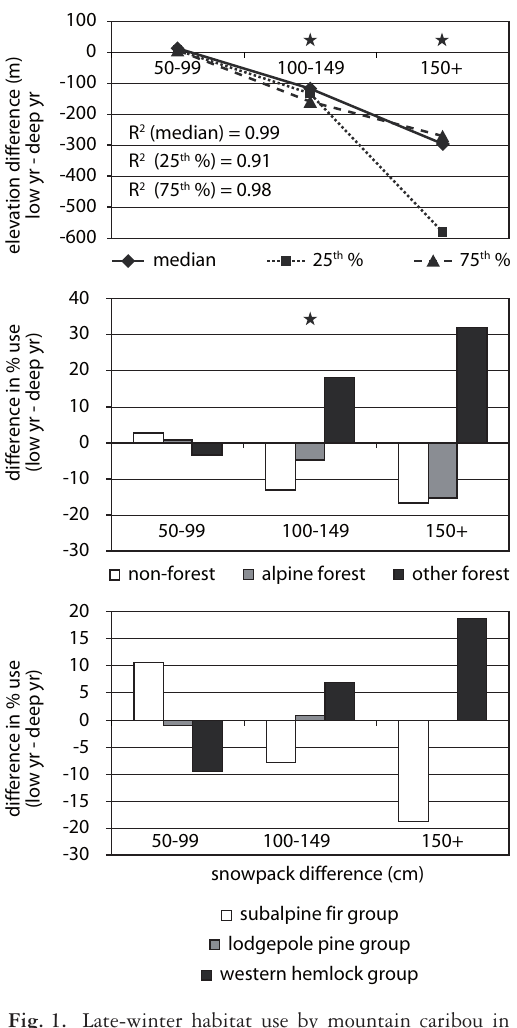
Fig. 1. Late-winter habitat use by mountain caribou in low-snow relative to deep-snow years based on equal random samples from all available subpop- ulations in wet and very wet ESSF subzones ( n =336 low/192 deep locations from 8 subpopu- lations at 50-99 cm, 140/168 from 7 subpopula- tions at 100-149 cm and 30/75 from 3 subpopu- lations at 150+ cm; * = sig. difference at indi- cated snowpack